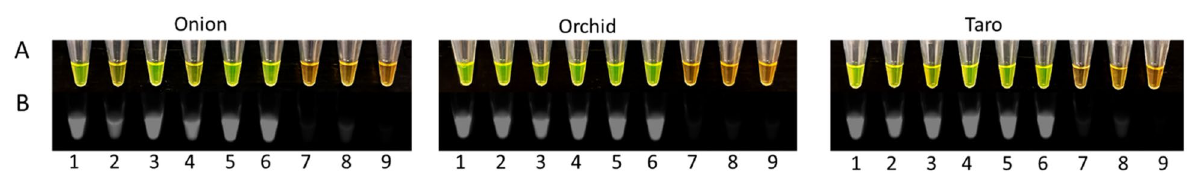
Figure 5. Detection limit determination of the loop mediated isothermal amplification (LAMP) assay designed for specific detection of Dickeya fangzhongdai in the presence of host matrices . Five µl of crude host lysate was added to purified genomic DNA (CFBP8607), tenfold serially diluted (from 10 ng to 1 fg) (tubes 1 to 8; tube 9 was non-template control). ( A ) Addition of SYBR Green I dye—a bright green color indicates positive amplification; ( B ) tubes observed under UV light—fluorescence indicate positive amplification. Amplification was observed for concentrations as little as 100 fg (tube 6), indistinguishable from the limit of detection obtained without the addition of crude host